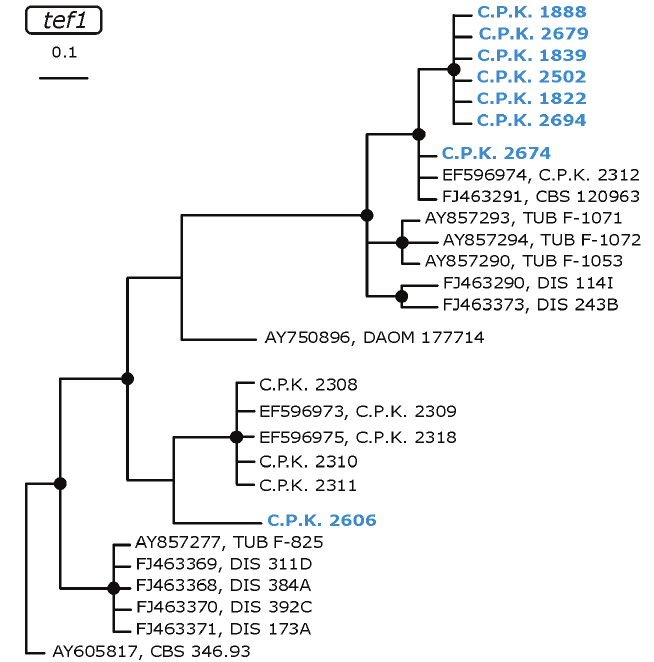
Figure 3. Identification phylogram of Ethiopian tef1 alleles (in blue) of T . spirale based on a Bayesian analysis. Nodes marked by black circles indicate posterior probabilities >0.94. All reference strains are given by the accession number of the corresponding tef1 sequence in GenBank and the strain